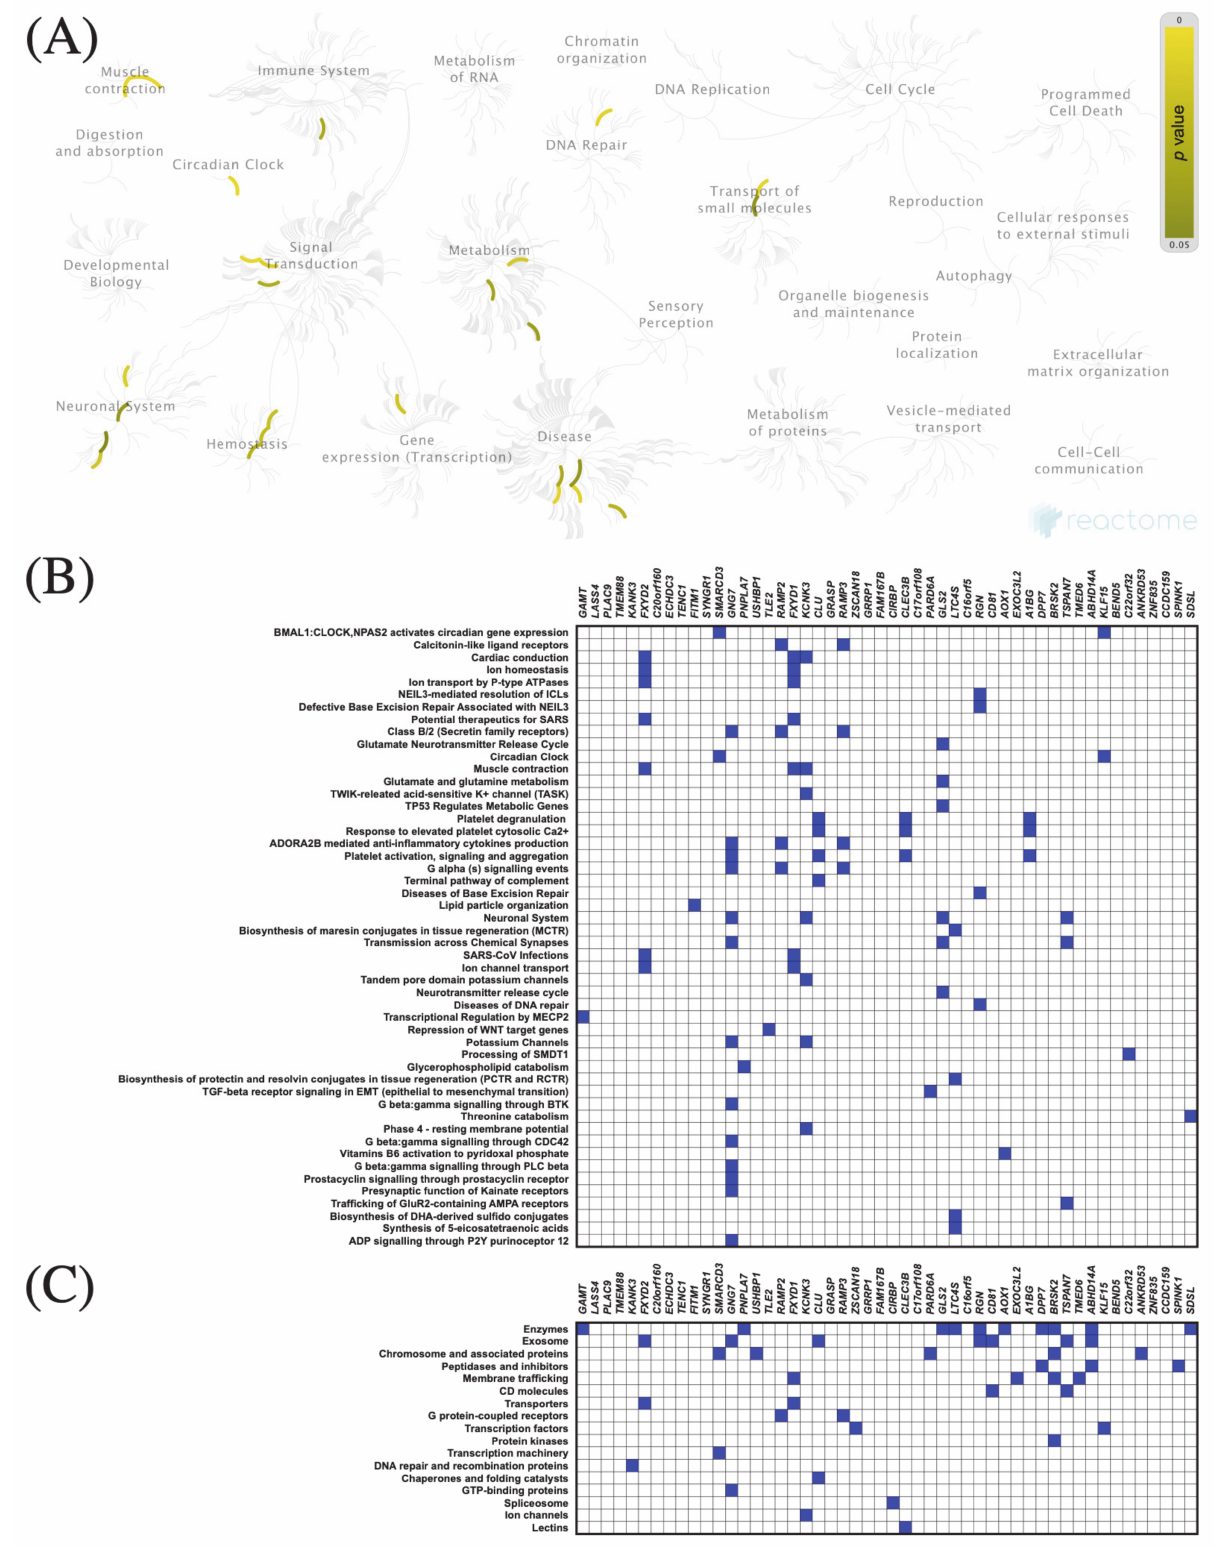
Figure 8. Functional enrichment analysis based on the TCGA dataset and UALCAN web tool. ( A , B ) The top 50 genes and Reactome pathways negatively correlated with KIF14 expression; ( C ) BRITE functional hierarchies for the top 50 genes that were co-downregulated with KIF14